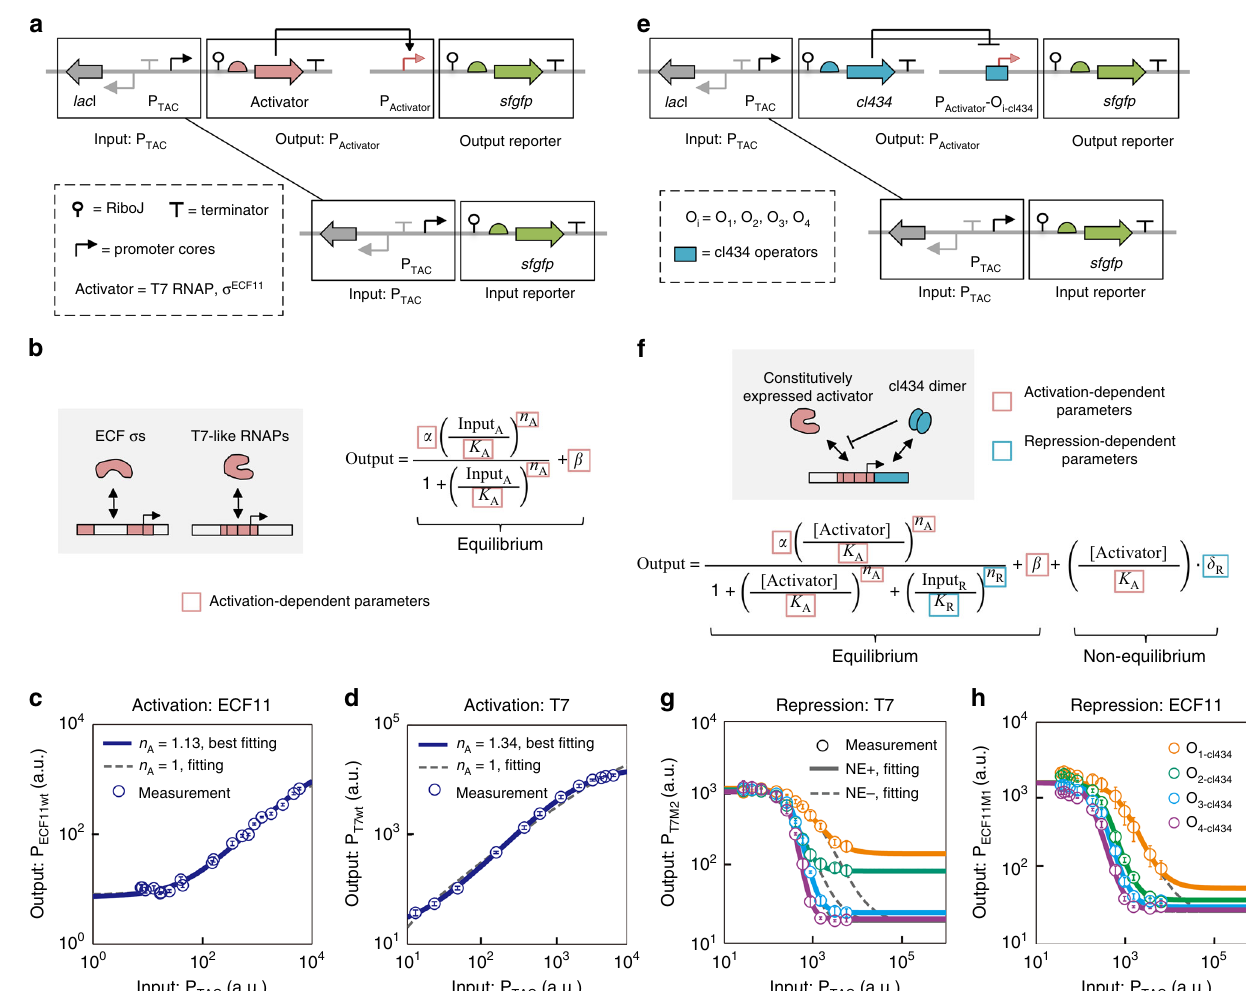
Fig. 3 Biophysical modeling and parameterization of transcriptional activation and repression. a Schematic of genetic circuits used for the characterization of promoter cores. The expression level of each transcriptional activator was determined via fl uorescence values of sfGFP transcribed from an independent cassette using the identical input promoter. b The biophysical model used to describe the interactions between promoter cores and their cognate transcriptional activators. c and d Experimental measurements and parameter fi tting of response functions for σ ECF11 c and T7 RNAP d . Solid lines denote parameter fi tting when n A was relaxed; dashed lines represent fi tting of results with fi xed n A values. e Schematic of genetic circuits used for the characterization of repressor operators. The transcriptional activator was constitutively expressed and thus omitted for clarity. The expression level of each transcriptional repressor was determined via fl uorescence values of sfGFP transcribed from an independent cassette using the identical input promoter. f Biophysical model used to describe the interactions between activator – promoter-core and repressor – operator pairs that determine transcriptional repression. The [Activator] value was constant because the transcriptional activator was expressed constitutively. A non-equilibrium term was introduced as a correction term for non-equilibrium effects. g and h Experimental measurements and parameter fi tting of response functions for cI434 at P T7 g and P ECF11 h . Solid lines denote parameter fi tting using a non-equilibrium correction term; dashed lines represent fi tting without the non-equilibrium term. Data represent the means ± SD from at least three replicate experiments. NE,